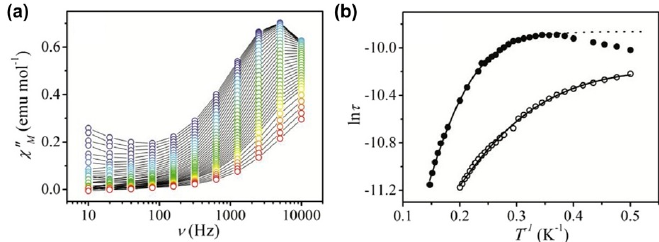
Figure 20. ( a ) Frequency dependence of the out-of-phase magnetic susceptibility of 35 , measured for different temperatures ranging from 2.0 K (blue points) to 6.0 K (red points) measured with an applied magnetic field of 1 kOe; ( b ) Temperature dependence of the relaxation times measured with a static applied magnetic field of 1 kOe (empty circles) and 1.5 kOe (full circles) along with the corresponding best fitting lines. Figures and captions are reproduced from Reference [56] with permission from the Elsevier Ltd.